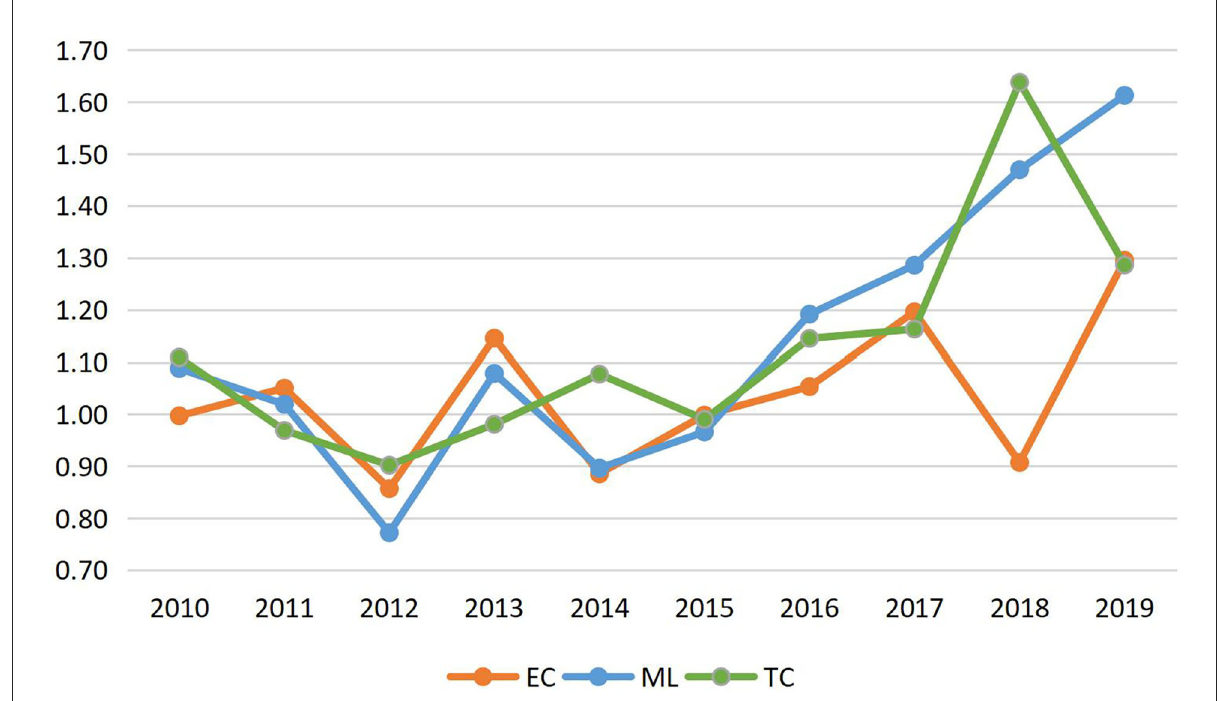
FIGURE2 Tourism machine learning (ML) index and its decomposition in Inner Mongolia from 2009 to